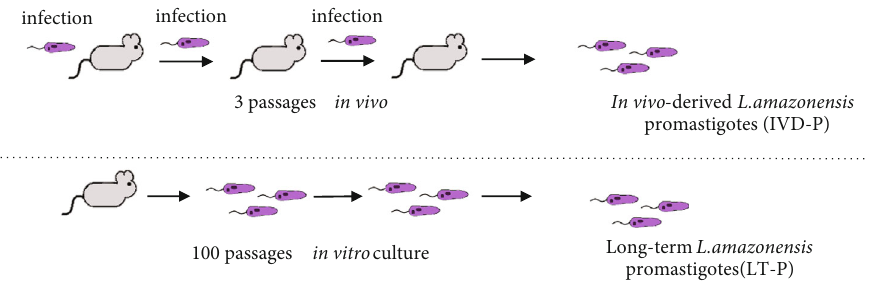
Figure 1: Scheme for obtaining L. amazonensis parasites with di ff erent virulence pro fi les (IVD-P and